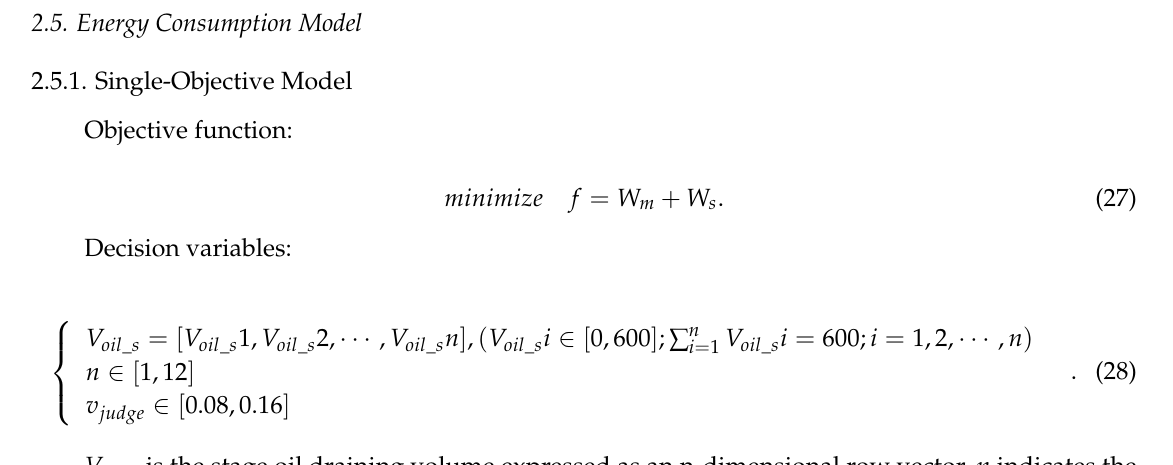
Figure 15. The process of the stage quantitative oil draining control